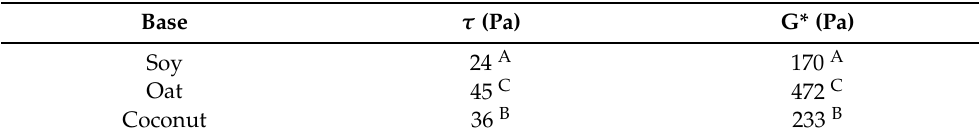
Table 4. Shear stress ( τ ) and complex modulus (G*) of fermented soy, oat, and coconut samples at a